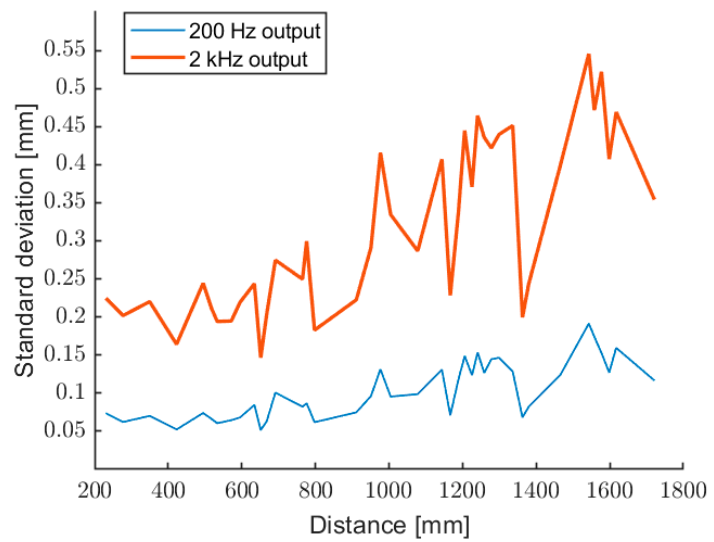
Figure 13. Absolute standard deviation of the measured distance, for the outputs at 2 kHz (upper trace) and 200 Hz (10 averages).